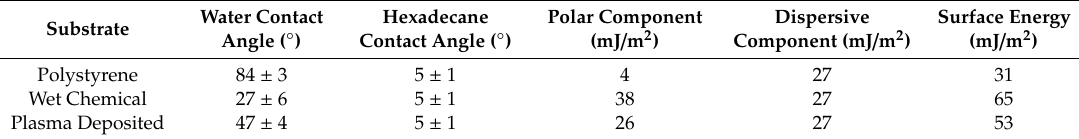
Figure 6. (top) Scanning Electron Microscopy (SEM) images of 6-well plates with ( A ) plasma deposited rat tail collagen, ( B ) wet chemical deposition of rat tail collagen, and (bottom) Atomic Force Microscopy (AFM) images of 6-well plates with ( C ) plasma deposited rat tail collagen, ( D ) wet chemical deposition of rat tail collagen. Table 1. Surface Energy